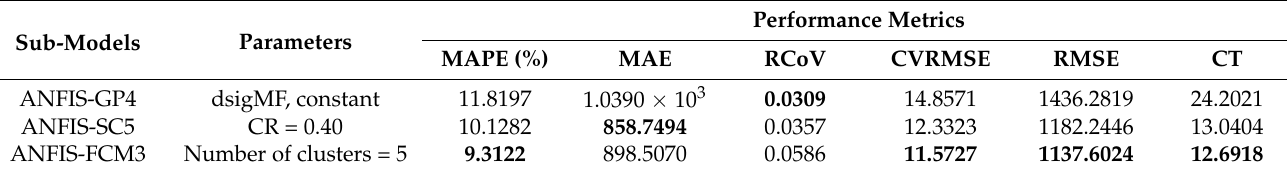
Table 7. Optimal sub-models comparison.